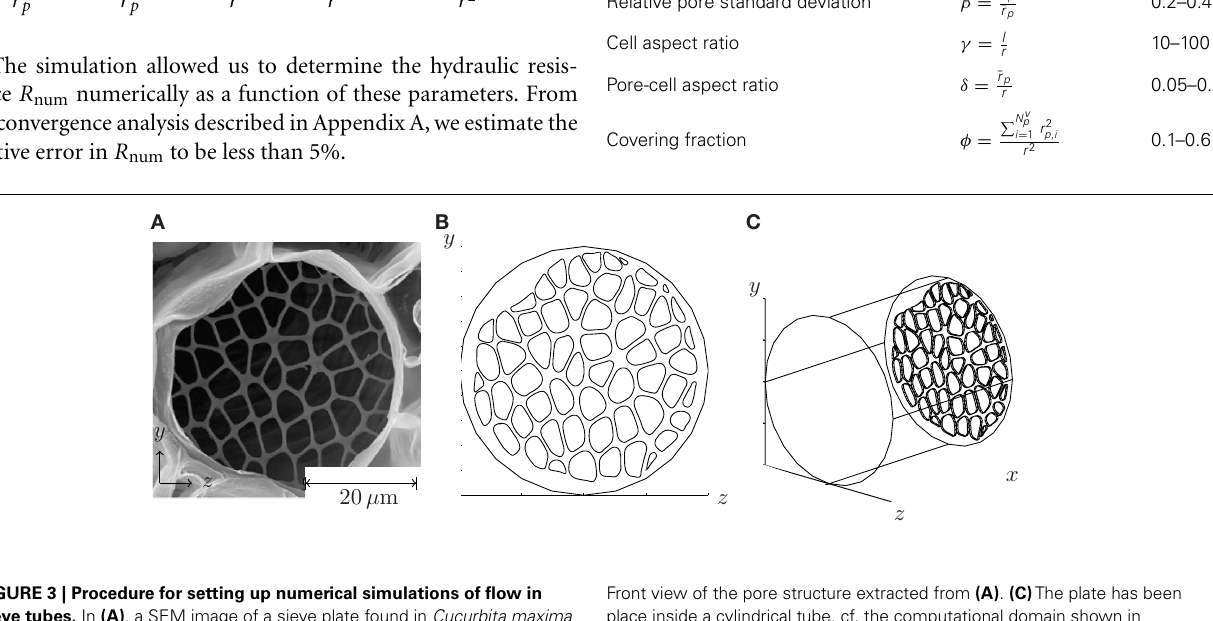
FIGURE 3 | Procedure for setting up numerical simulations of flow in sieve tubes. In (A) , a SEM image of a sieve plate found in Cucurbita maxima is shown. From Mullendore et al. (2010), reproduced with permission. (B)